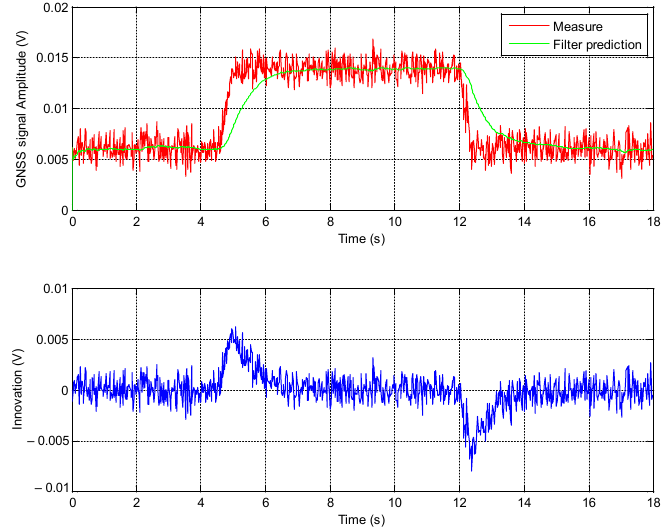
Figure 6. GNSS signal amplitude and filter innovation as a function of